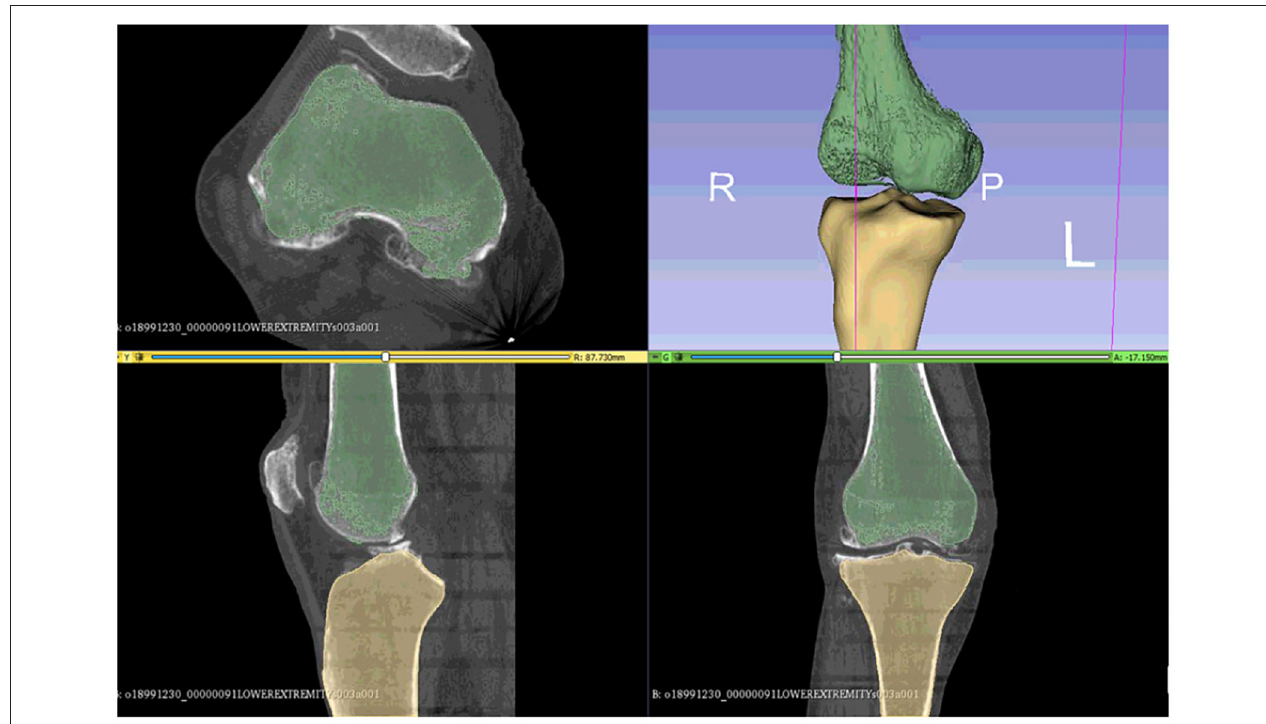
FIGURE 3 | The femur can be differentiated from the tibia and the tibia from fibula using the 3D Slicer’s algorithms that can separate regions corresponding to the same